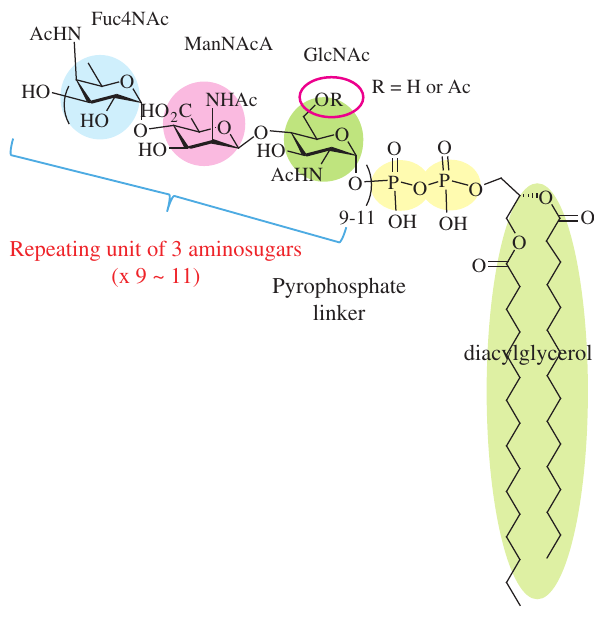
Figure 3 Structure of